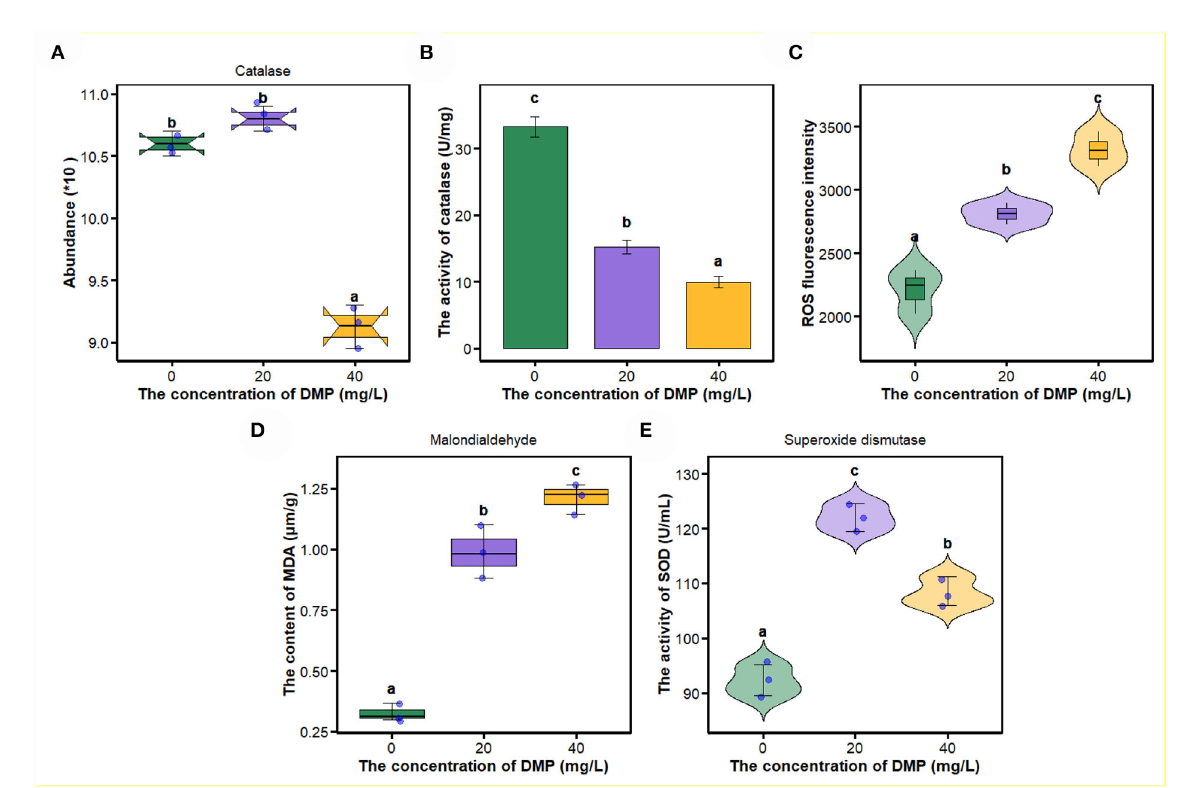
FIGURE4 The effect of DMP on the oxidative-reactive kinase system of the P. fluorescens . (A) indicates that DMP inhibited the expression of catalase abundance through proteomics; (B,E) show the activities of catalase (CAT) (B) and superoxide dismutase (SOD) (E) of P. fluorescens was changed by DMP treatment; (C,D) show reactive oxygen species (ROS) and malondialdehyde (MDA). Different letters represent significant differences between treatments.